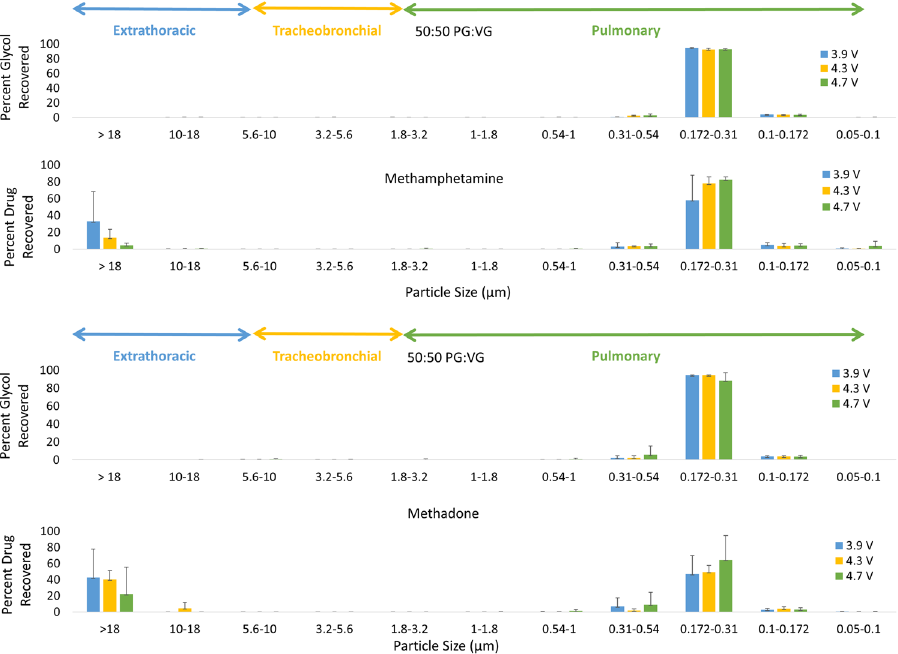
Figure 3. Particle size distribution of glycol, methamphetamine, and methadone by voltage at 1.8